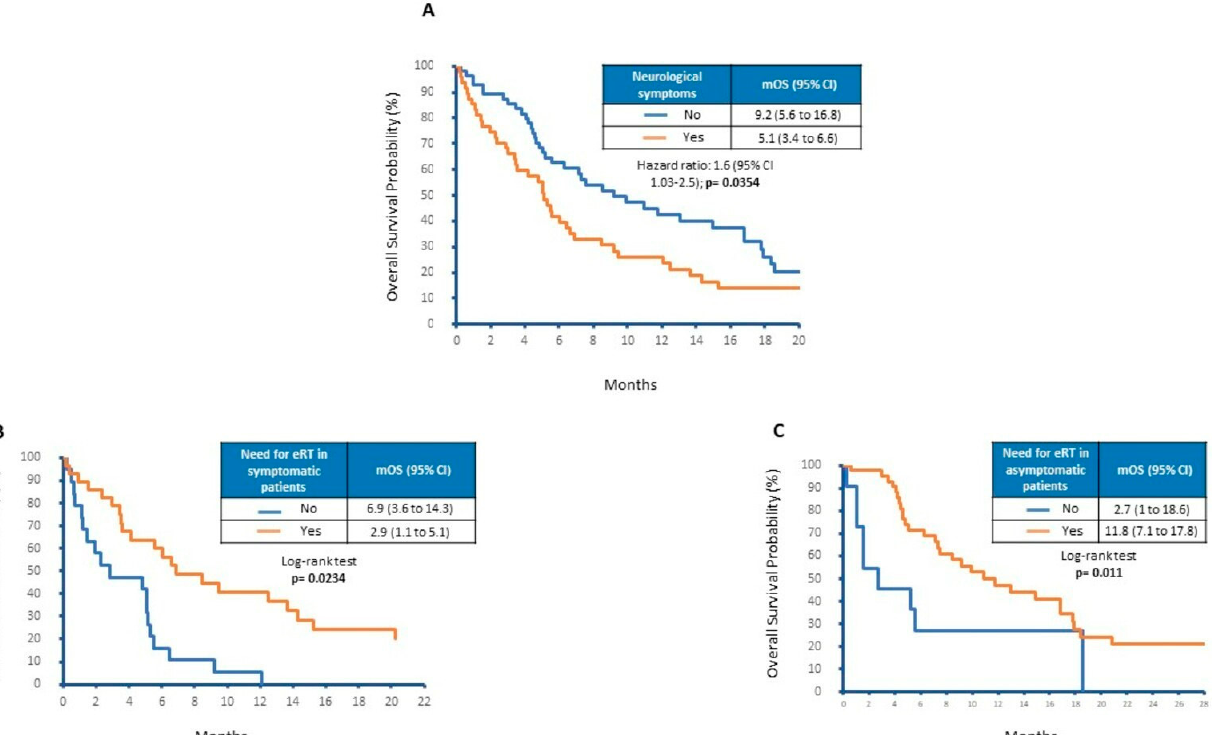
(mOS: 11.8 vs. 2.7 months, p = 0.011; Figure 1C).